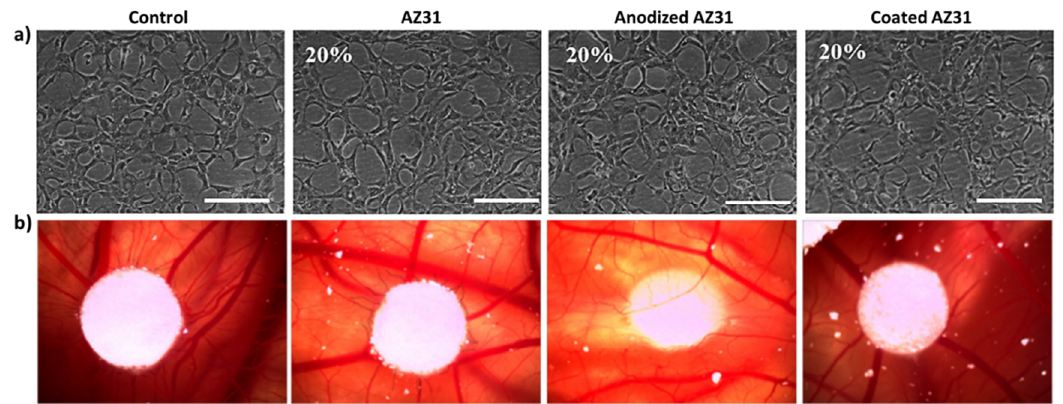
Figure 4. ( a ) The Matrigel assay: representative images of HUVECs cultured in control conditions and in the presence of the extracts from the Mg-based materials (20%), showing the organization of the cell layer in a network of cord-like structures upon the addition of Matrigel. Scale bar: 200 µm. ( b ) The CAM assay: effect of the extracts from the Mg-based alloys in the angiogenic response. Representative images of the angiogenic response surrounding the filter samples impregnated with the extracts.